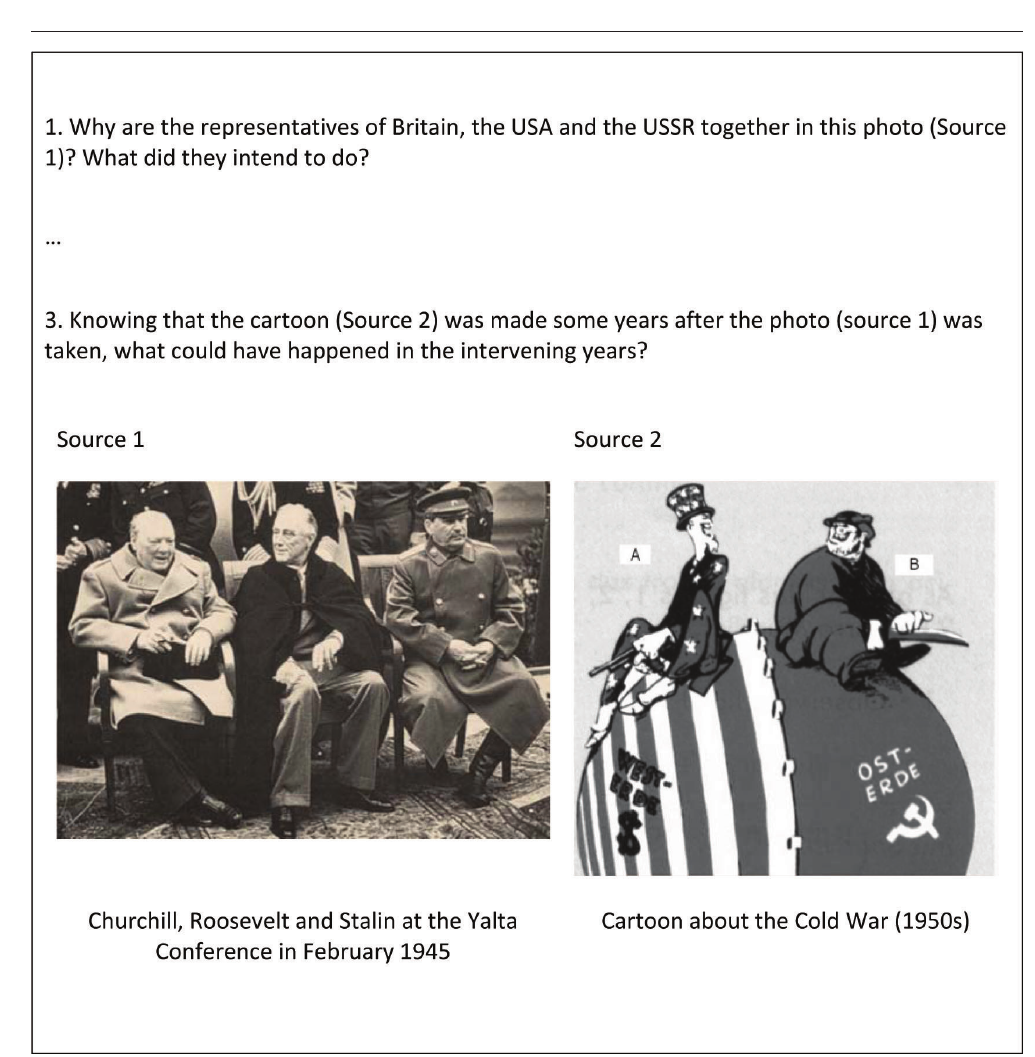
Figure 2: The task posed by the researcher about changes in the world between the end of the Second World War and the Cold